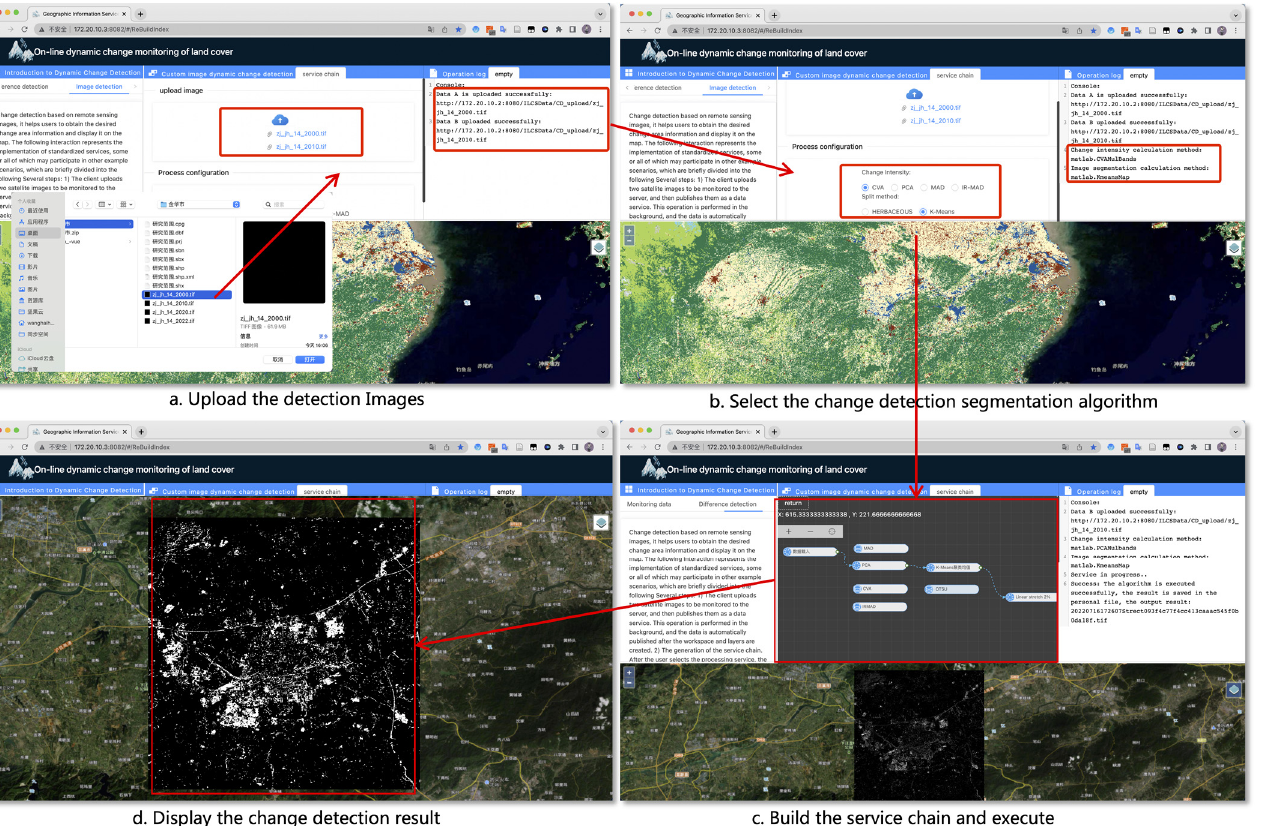
Figure 14. Application of comprehensive land cover change detection.